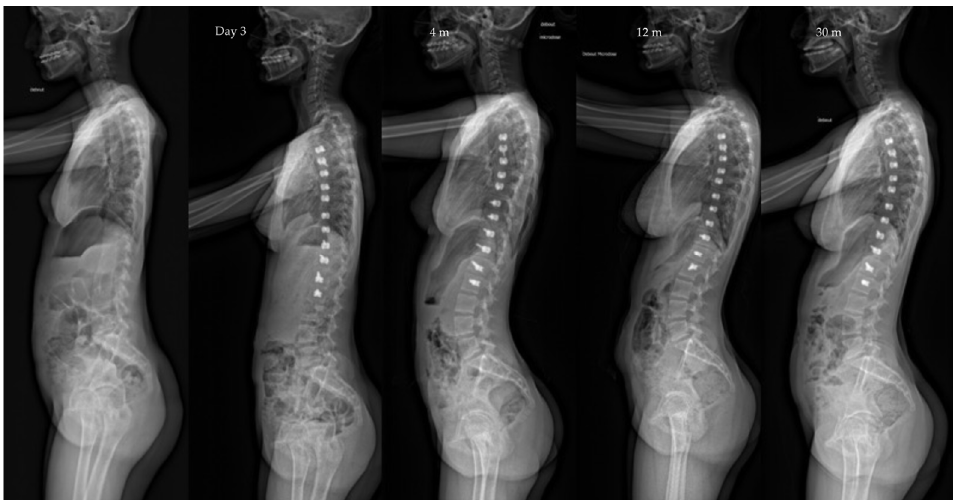
follow-up (2.5 y po), the major curve was measured at 9°.